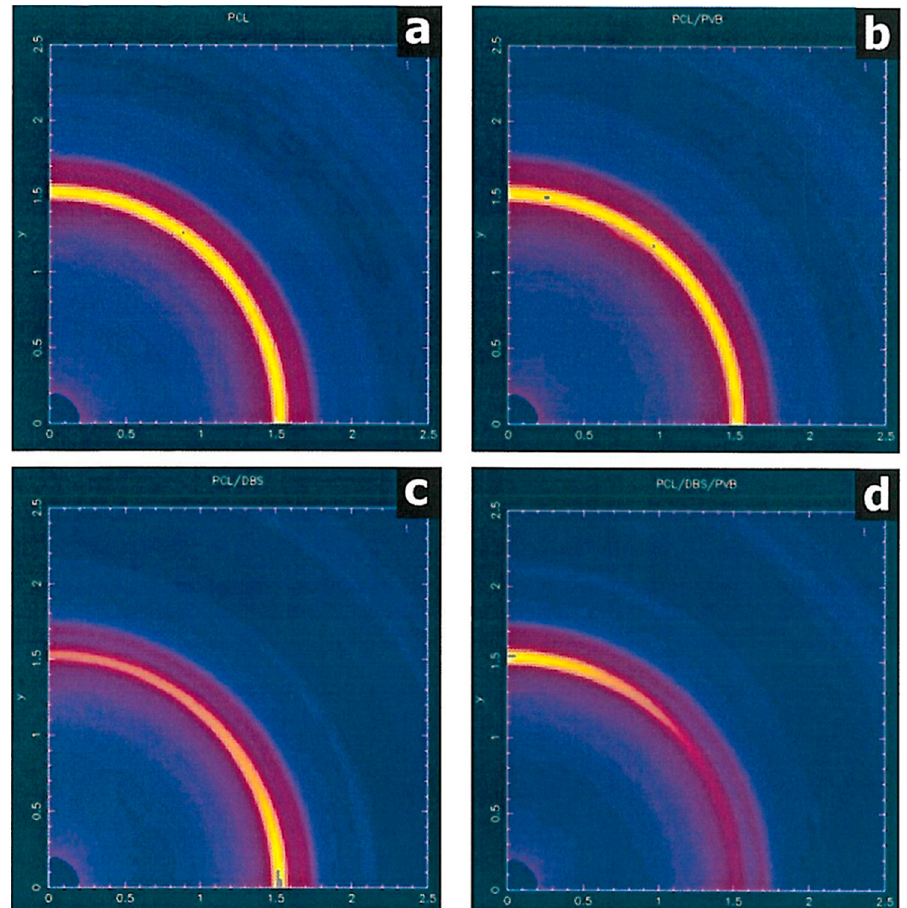
Figure 3. Maps of the wide-angle X-ray scattering (WAXS) intensity obtained for samples of ( a ) PCL; ( b ) PCL with 3%PVB; ( c ) PCL with 3% DBS; and ( d ) PCL with PVB and 3% DBS crystallised from a melt after a shear flow of I0 s − 1 for 100 s at 80 °C. The melt flow direction is vertical.